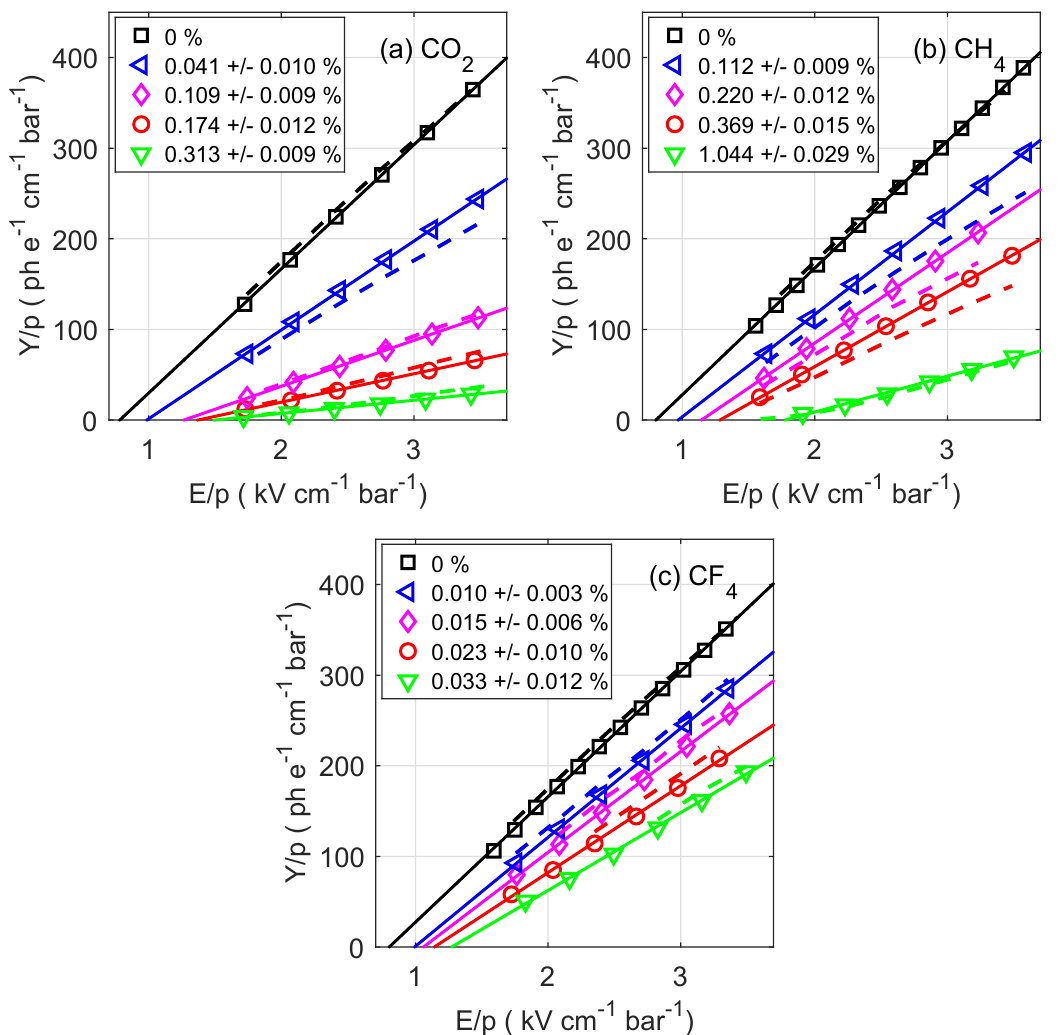
Figure 3 . Reduced EL yield obtained for 5.9 keV x-rays, Y=p , as a function of the reduced electric (cid:12)eld, E=p , for di(cid:11)erent concentrations of molecular gases added to pure xenon: (a) CO 2 ; (b) CH 4 ; (c) CF 4 . Total pressures of 1.13, 1.25 and 1.24 bar were used, in average, for Xe-CO 2 , Xe-CH 4 and Xe-CF 4 mixtures, respectively. Solid lines show linear (cid:12)ts to the data, while dashed lines are simulation values obtained with the code developed in